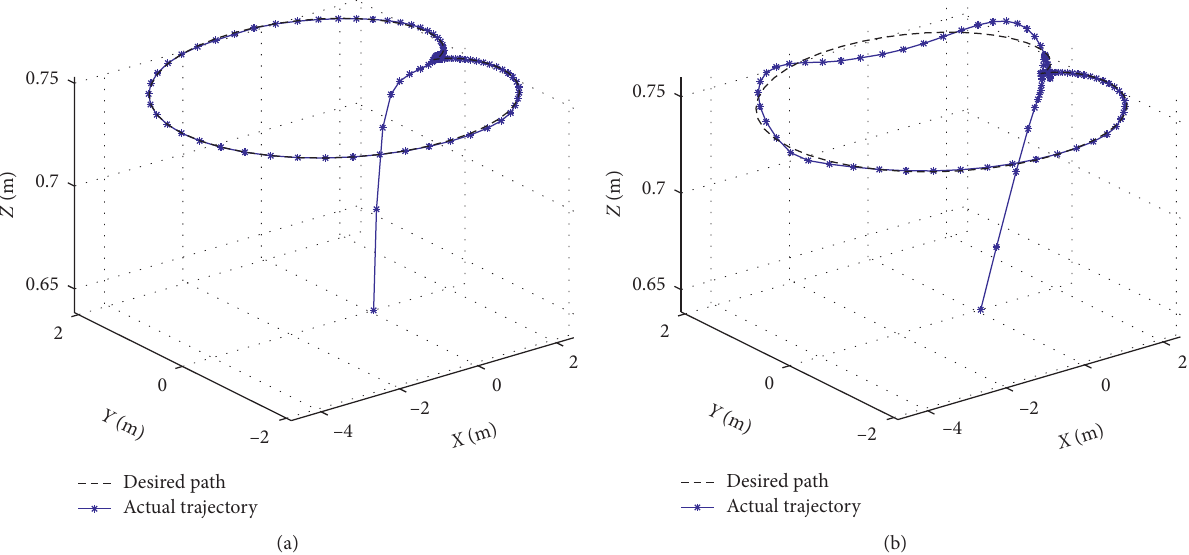
Figure 8: Desired path and actual trajectory synthesized by two models in the presence of vector-form noise. (a) Disturbed EVPNN model (33). (b) Disturbed ZNN model